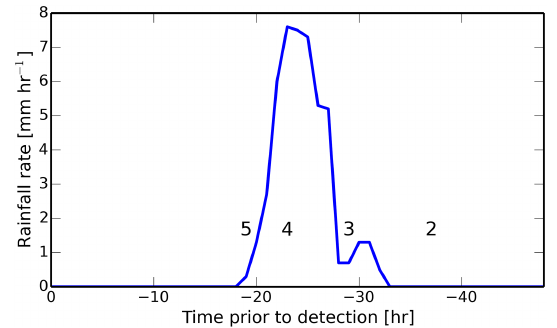
Figure 9. Precipitation rates along the HYSPLIT trajectory shown in Fig. 6 for the upper, potentially scavenged, air mass. The rainfall information was derived using the NCEP GDAS reanalysis. Time on the horizontal axis is measured in hours prior to detection of the air mass at the DGS. Numbers correspond to HYSPLIT positions marked in Fig. 6. The same analysis applied to the trajectories for the lower particle-rich plume does not show any significant precip- itation along the path (not